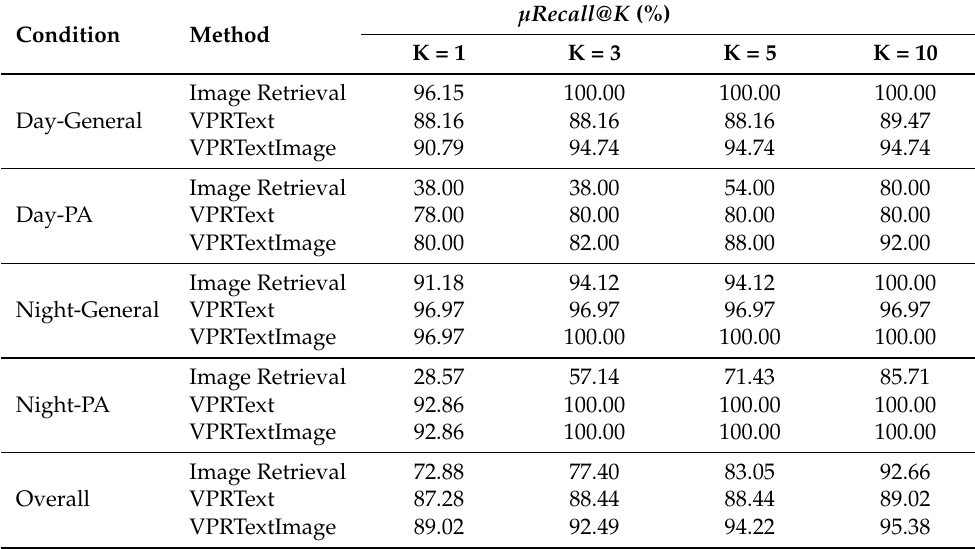
Table 5. Comparison between general and perceptually aliased